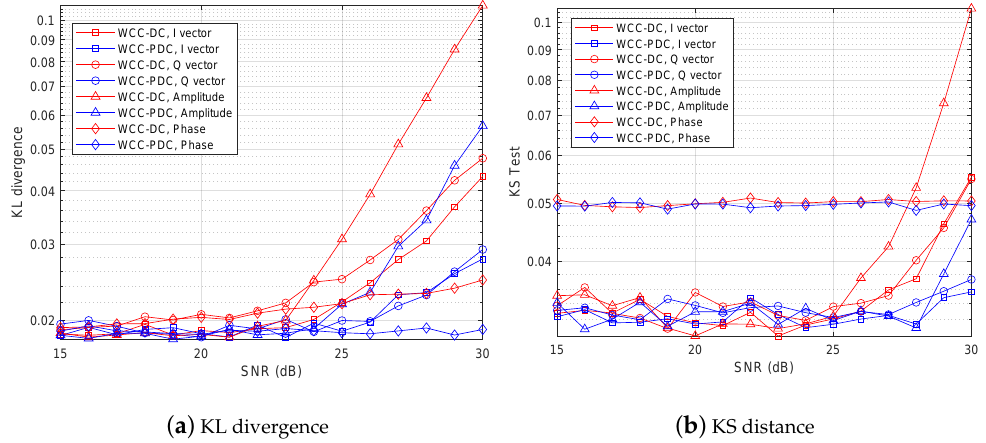
Figure 12. Detection values versus signal noise ratio at Willie, and CSR = 15